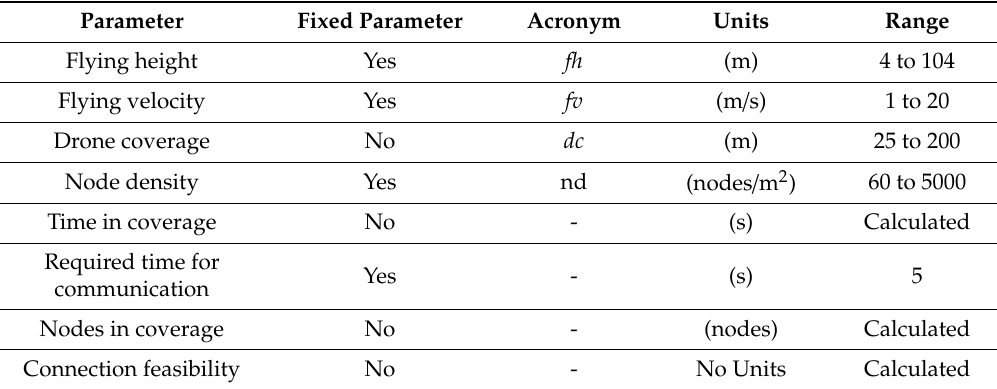
Table 3. Parameters included in our model.